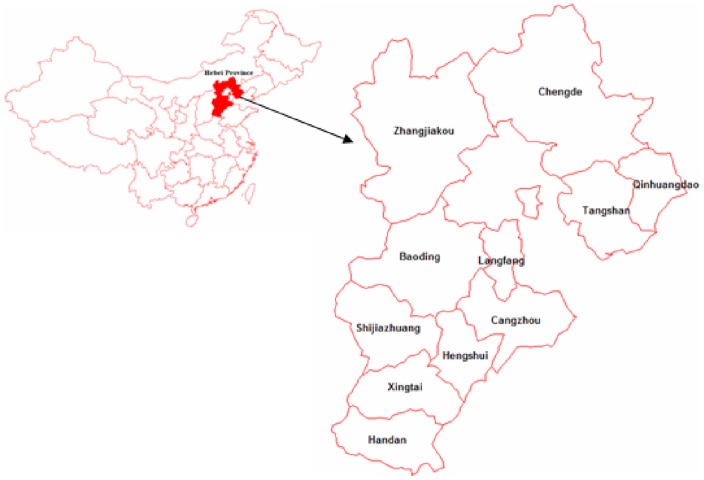
The location of Hebei province.